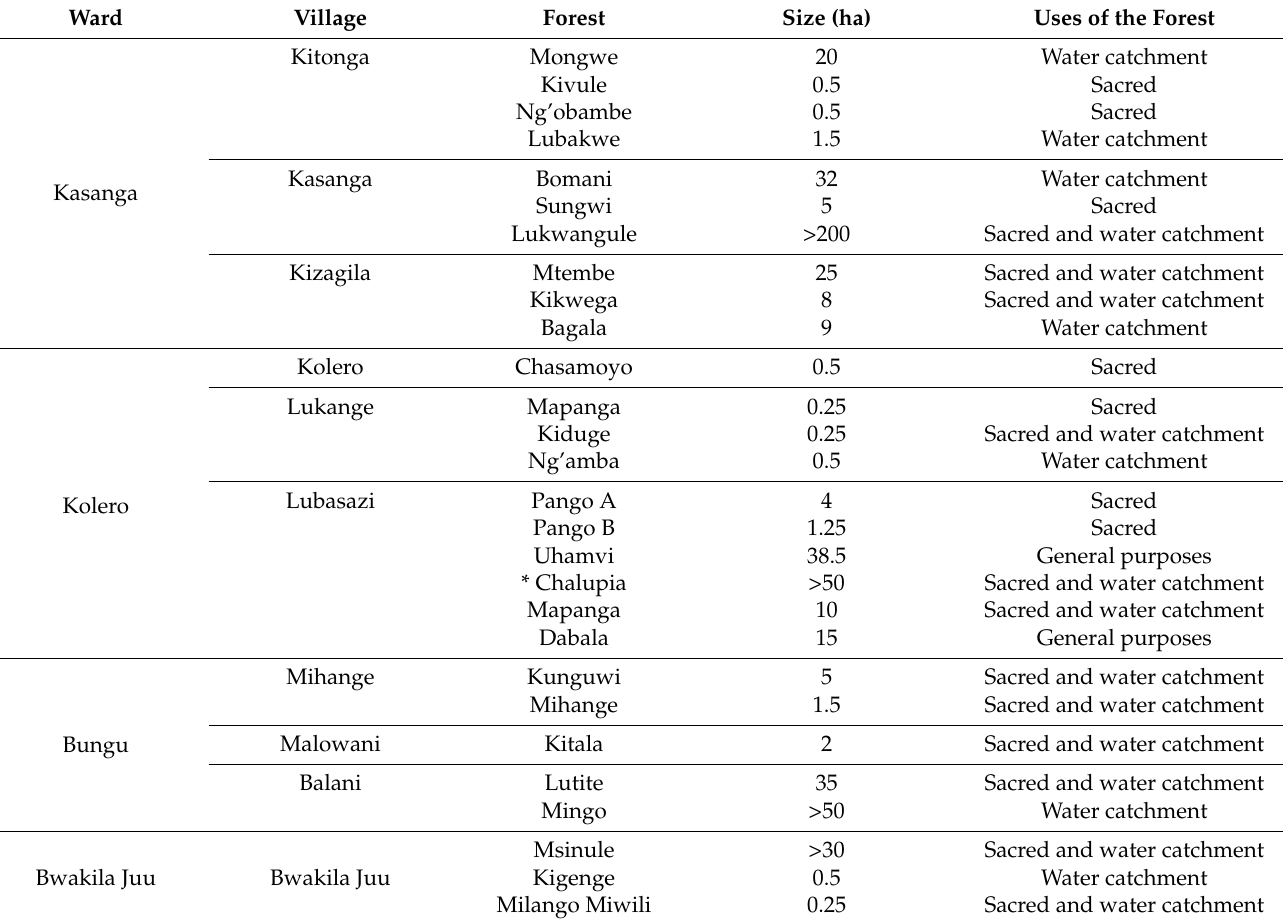
Table 2. Sacred and other general-purpose forests in the Kolero sub-catchment, Uluguru Mountains, Tanzania.